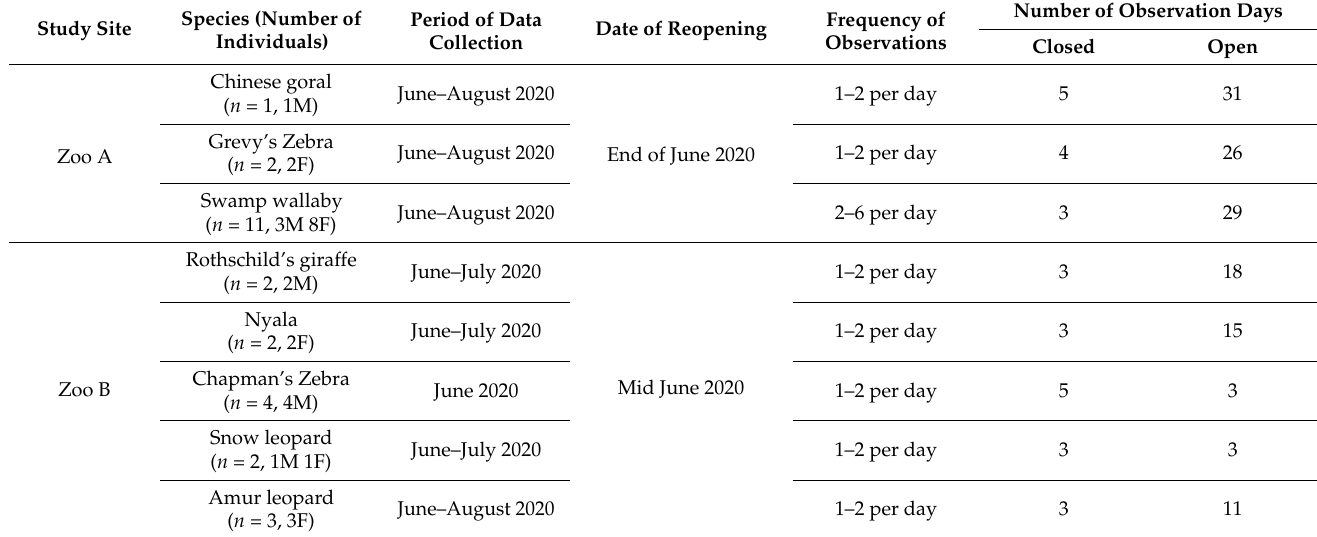
Table 1. Details of study sites and periods of data collection. M = male, F =